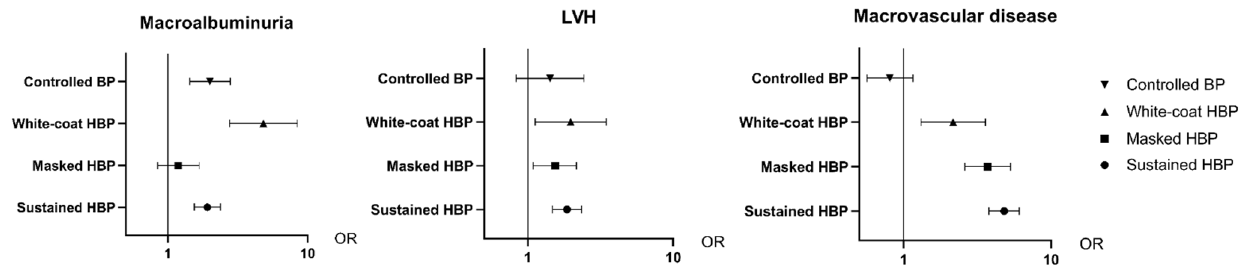
Figure 3. Stratified analysis for the association between different groups and target-organ damage in 4 different blood-pressure pattern groups using propensity score weighting ( n = 1002). LVH—eft ventricular hypertrophy. OR—odds ratio.